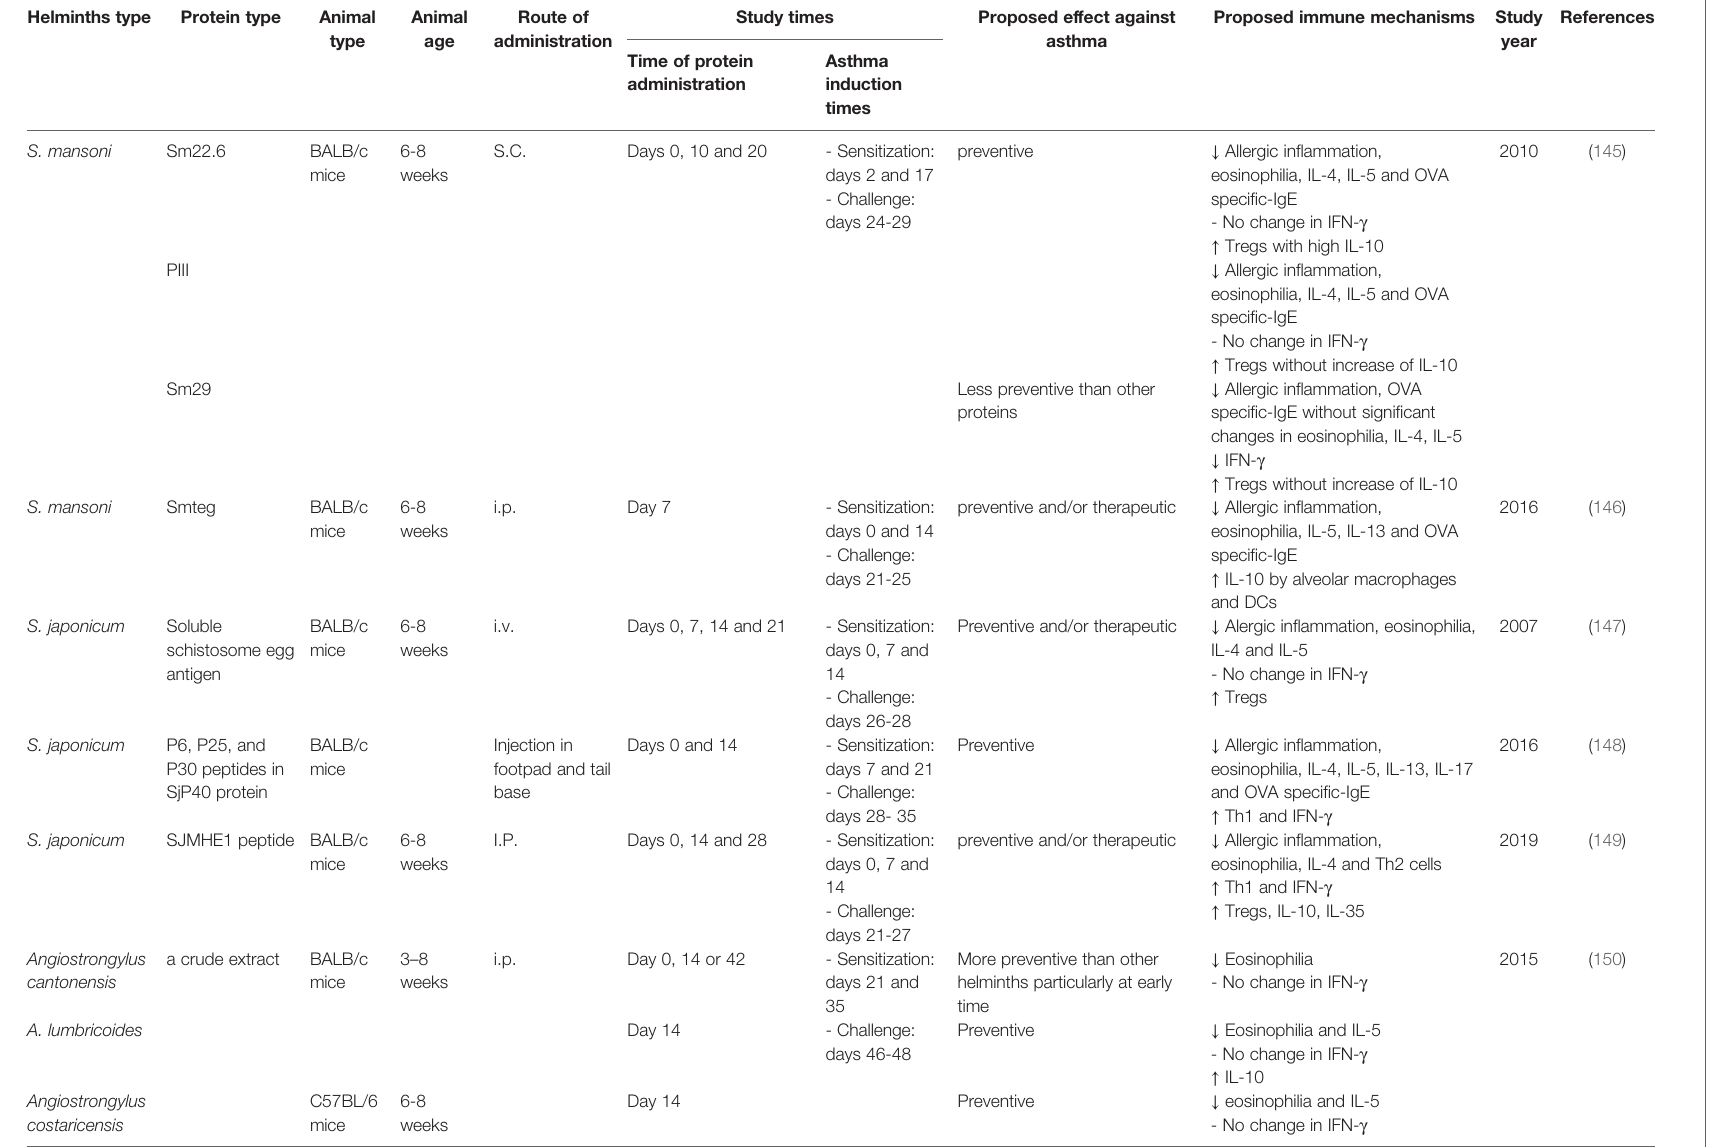
TABLE 5 | Impact of helminth-derived proteins on allergic